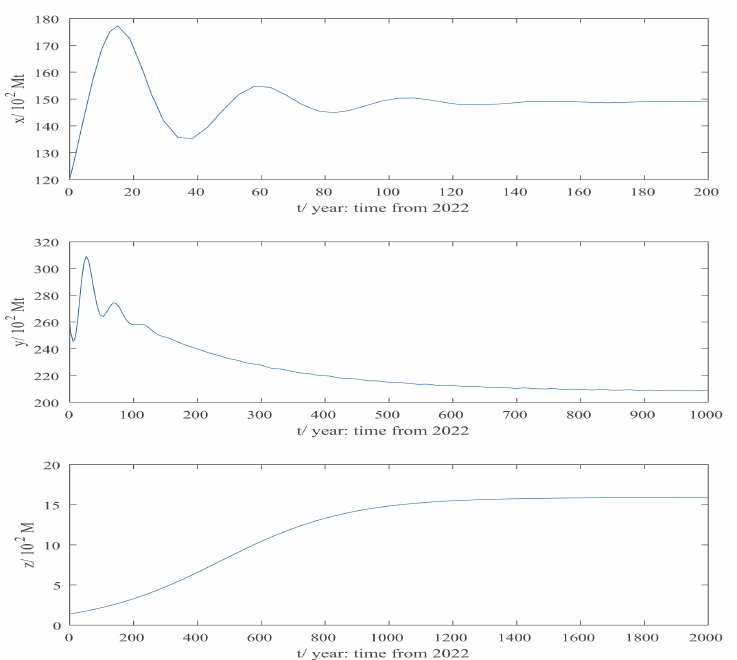
Figure 4. Equilibrium point E ∗ of system (3) is locally asymptotically stable when τ = 5 under the first group of